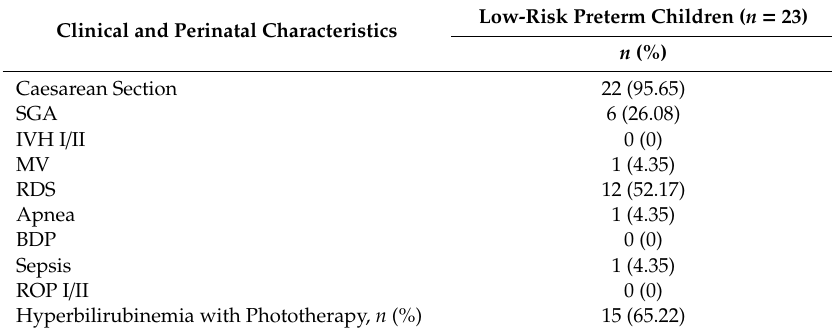
Table A1. Clinical and Perinatal Characteristics of Low-Risk Preterm Children. Clinical and Perinatal